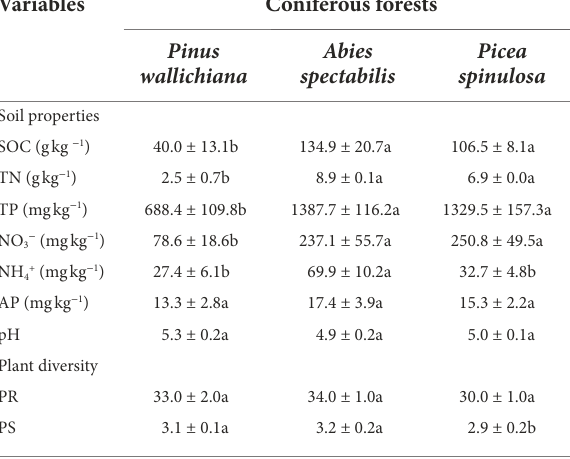
TABLE 1 Soil properties and plant diversity indices across the three studied coniferous forest